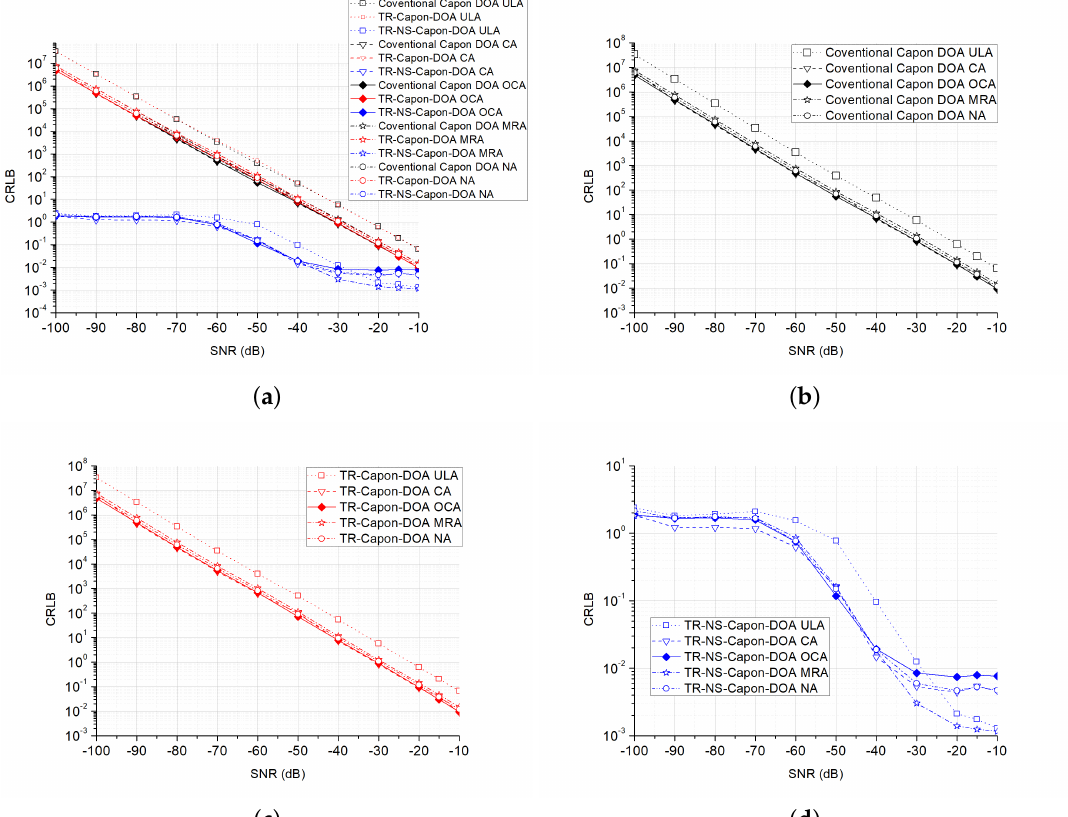
Figure 15. CRLB versus SNR for conventional Capon DOA, TR-Capon-DOA and TR-NS-Capon-DOA algorithms with the configurations of ULA, CA, OCA MRA and NA under the condition of LFM used as ES and DOA = 32 ◦ , ( a ) all methods and configurations; ( b ) the conventional method and all configurations; ( c ) the TR-Capon-DOA method and all configurations; ( d ) the TR-NS-Capon-DOA method and all